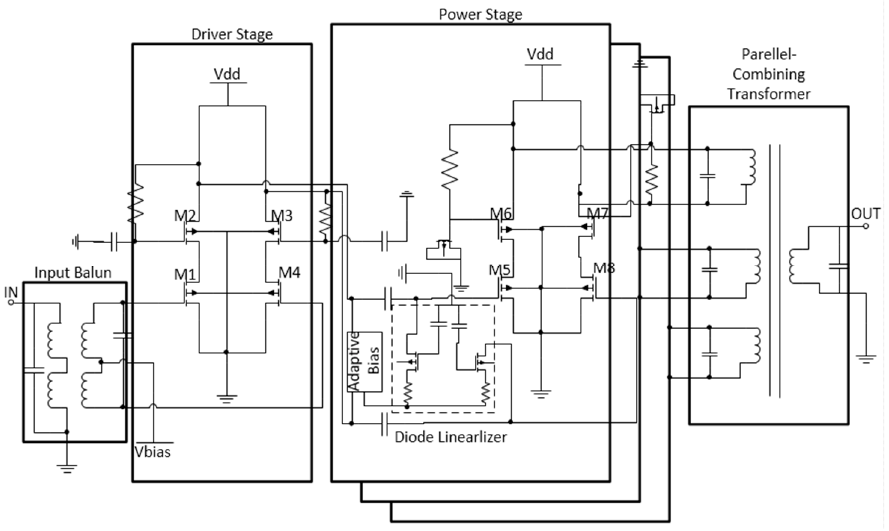
Figure 15. Schematic of 2.4 GHz PCT PA [48].